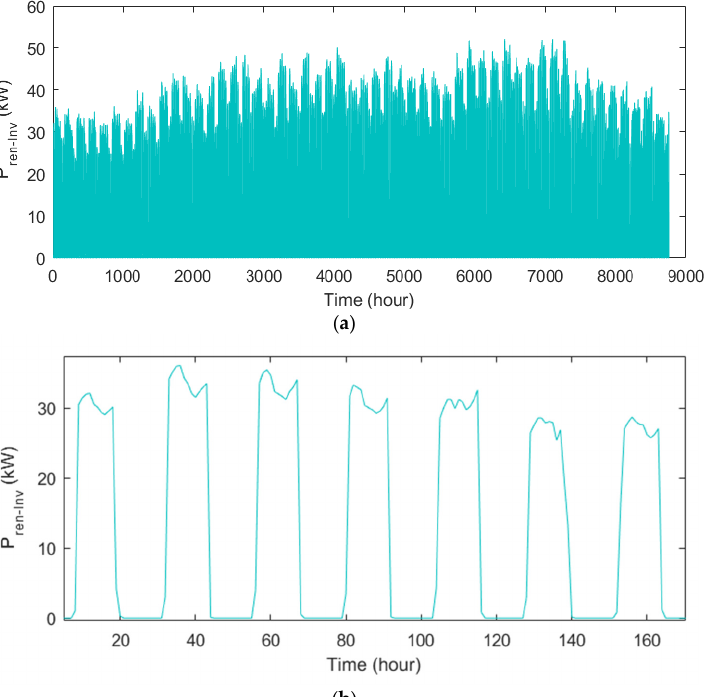
Figure 15. Delivered power to the inverter by the PV resources in the sizing of the HPV/FC energy system via the IAEO, considering ENSP max = 5% during ( a ) a year and ( b ) a week.